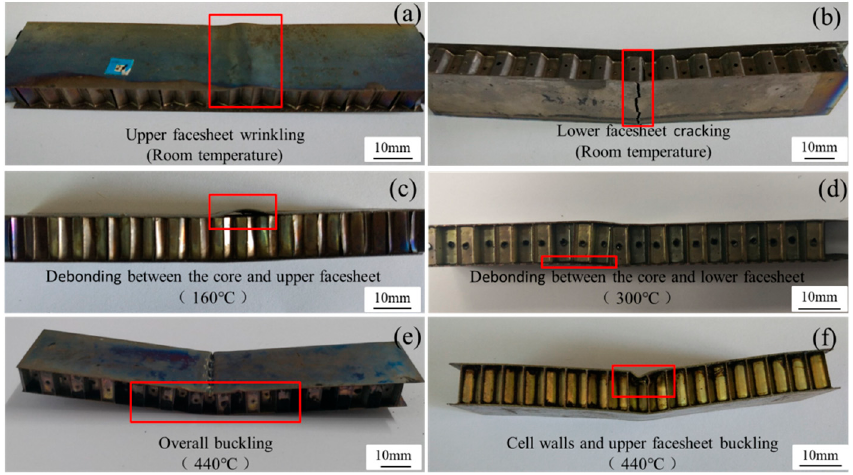
Figure 10. Failure modes of the vented honeycomb sandwich panels.